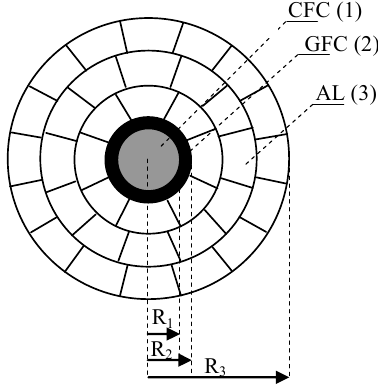
Figure 1. Cross-section of the aluminum conductor composite core (ACCC) conductor.